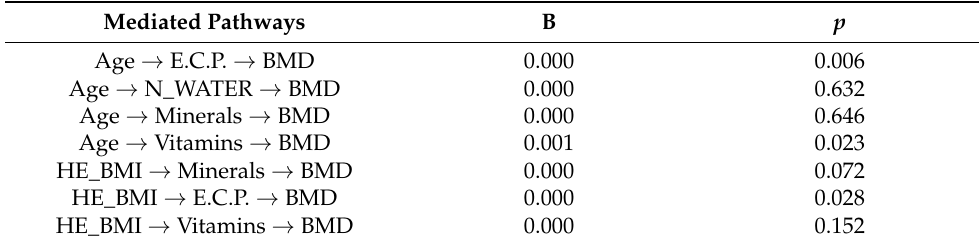
Table 6. Results of mediated pathways in premenopausal women with bone mineral